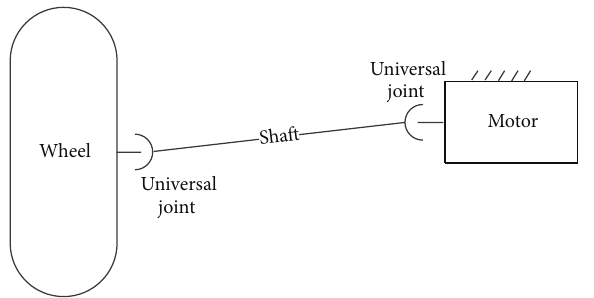
Figure1:Schematicdiagramofpositioningthemotoronthevehicle body.